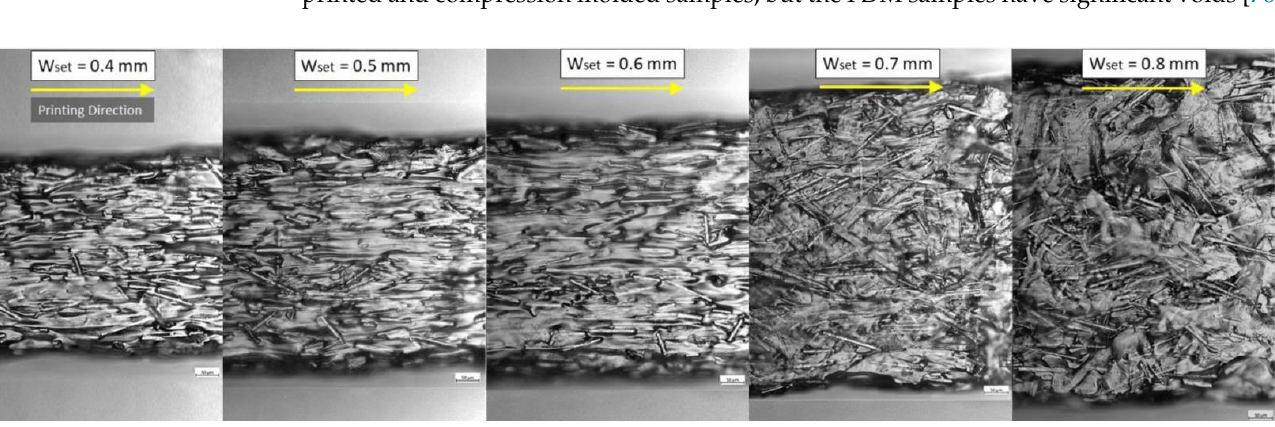
Figure 11. Fiber orientation at different extrusion width (W set ), where fibers were more aligned in a narrow extruder compared with a wider extruder. Reprinted with permission from[118], 2022, Elsevier, Amsterdam, The Netherlands.